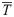
HIV/HPV co-infection.(a) HPV W and (b) CTL E as given by model (6) for ε = 0.5 per day, parameters are listed in Table 1, and T¯ = 106 cells per ml (blue solid lines); T¯ = 5x105 cells per ml (red dashed lines); T¯ = 3.3x105 cells per ml (green dotted lines); and T¯ = 2x105 cells per ml (purple dashed-dotted lines).